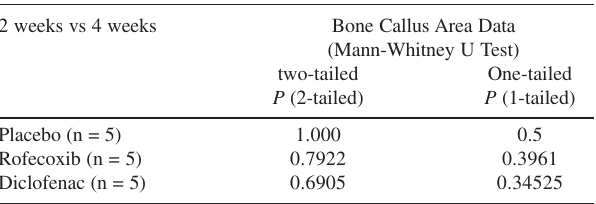
Table 2 - Intragroup comparison of bone callus area related to the time of sacrifice (2 vs 4 weeks after osteotomy) 2 weeks vs 4 weeks